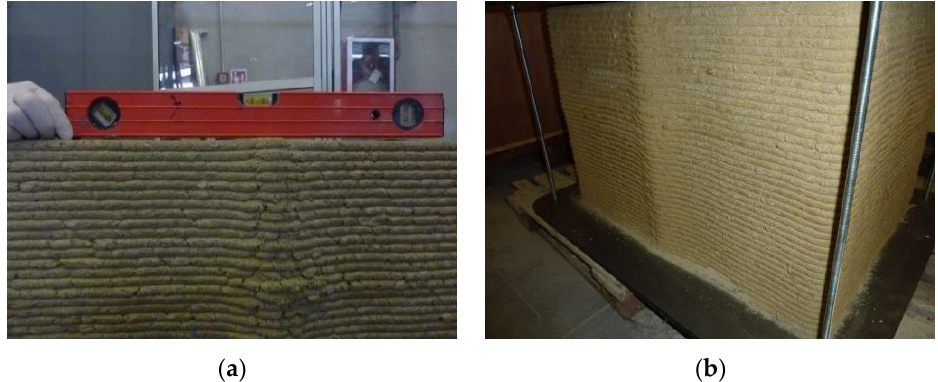
Figure 6. 3D-printed specimen in the hardened state: ( a ) excess material on the upper face; ( b ) excess material on the rear side (long side face opposite the operator).